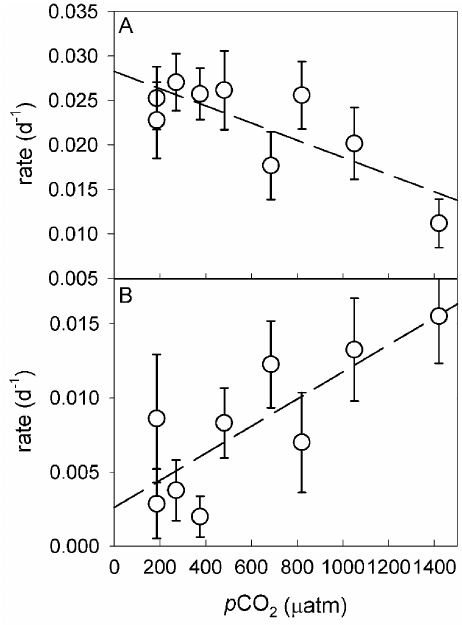
Fig. 6. Model parameters (d − 1 ) with uncertainties for (A) zooplank- ton grazing rates (µ g ) and (B) sinking rates ( r sink ) vs. average p CO 2 levels in phase